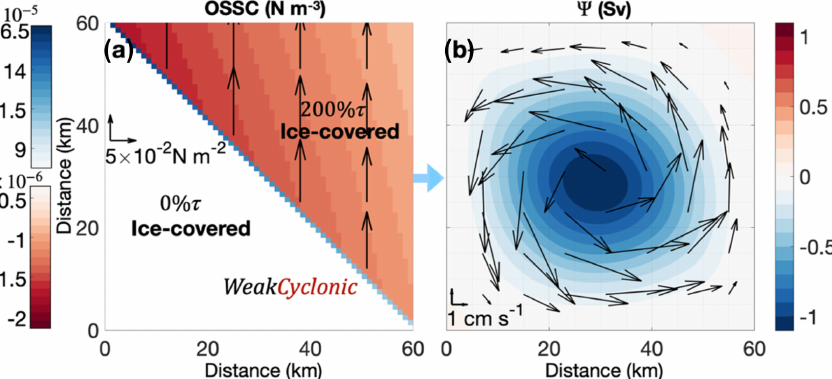
Figure 14. Ocean surface stress curl (OSSC) and simulated gyre streamfunction ( (cid:57) ) for the simulation with the WeakCyclonic wind field. Sea ice covers the whole model domain. Sea ice in the northeast has 200% of τ transferred to the ocean (representing mobile ice) while sea ice in the southwest has 0% of τ transferred to the ocean (representing fast ice). (a) The shading indicates the OSSC and the arrows indicate the wind stress. (b) The shading indicates the simulated gyre (cid:57) and the arrows indicate the current